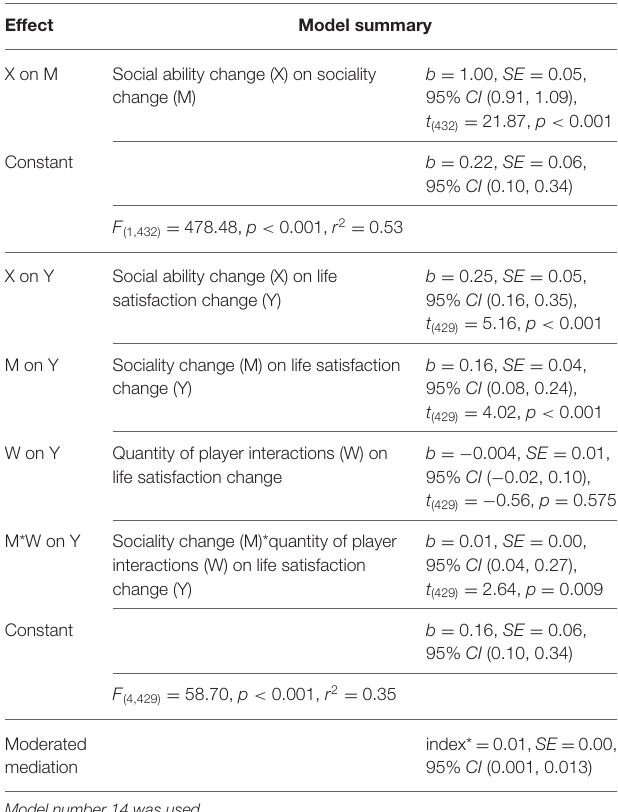
TABLE 2 | Moderated mediation model predicting the change in life